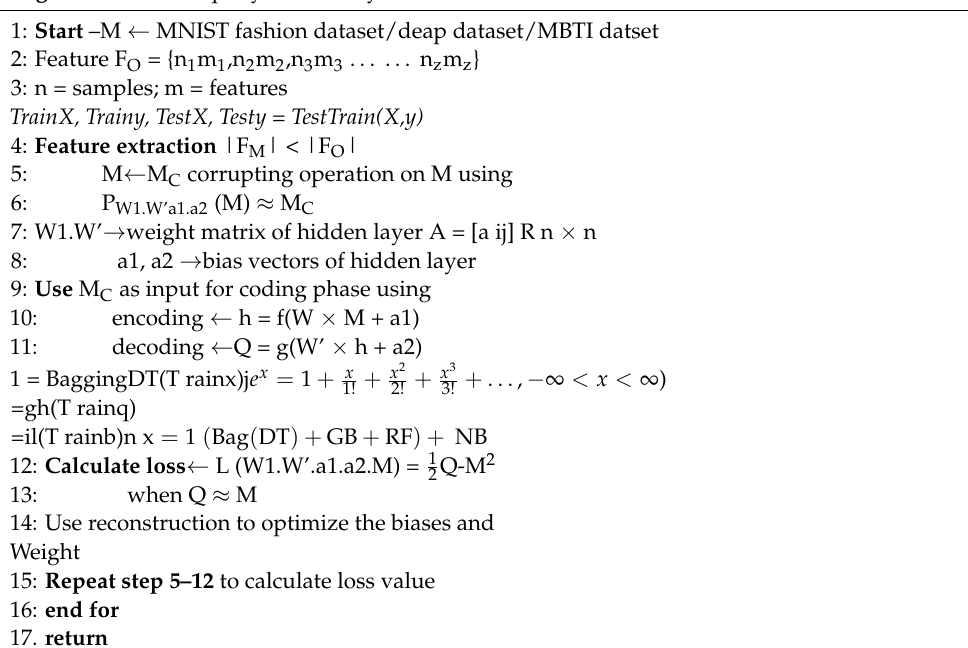
Algorithm 1 : CBIR query retrieval